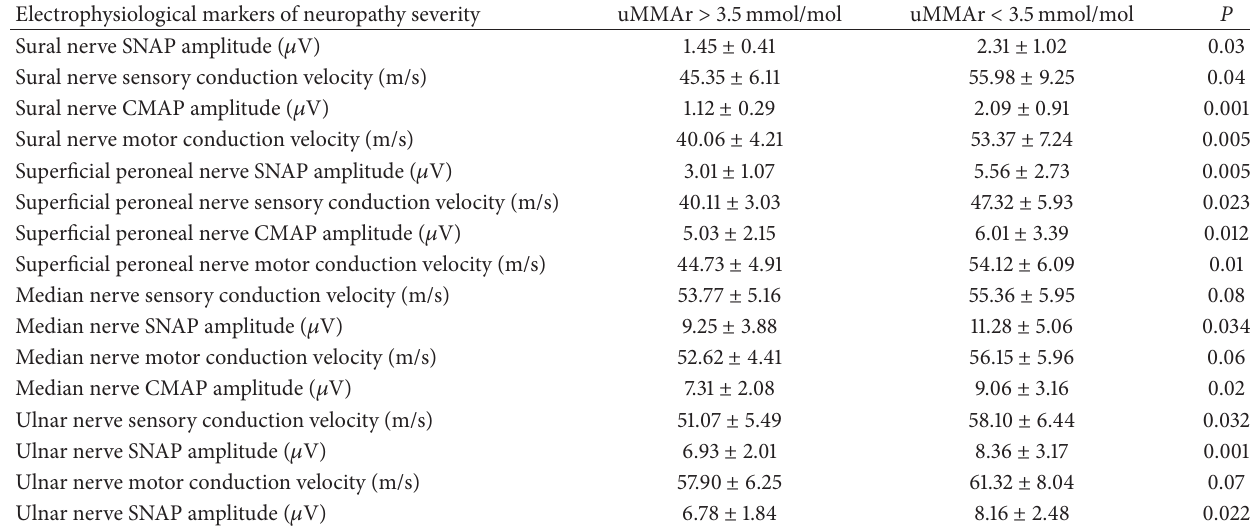
Table 3: Prevalence of electrophysiological markers of neuropathy severity according to urinary methylmalonic acid/creatinine. Electrophysiological markers of neuropathy severity